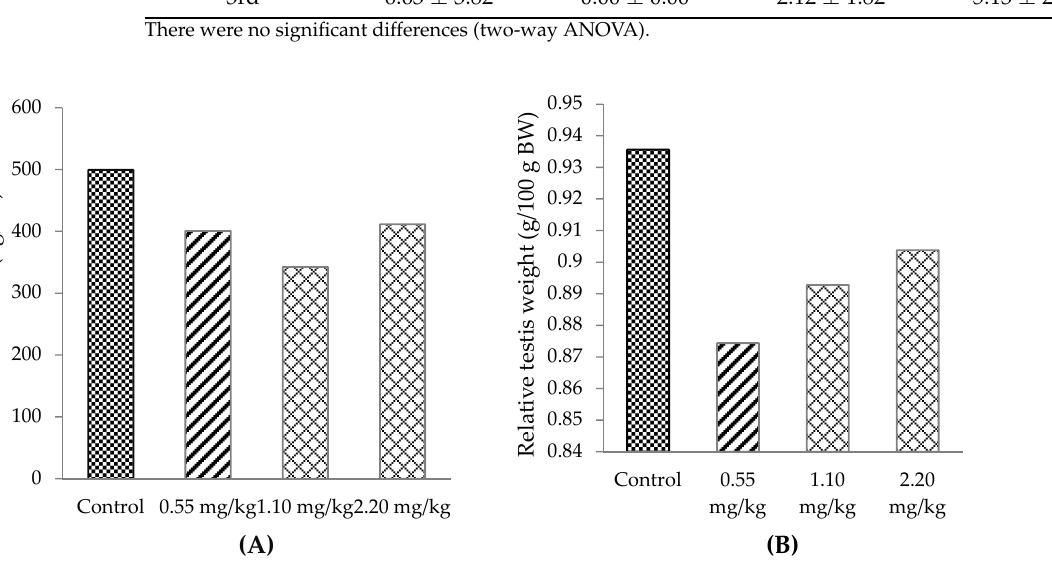
Figure 4. Testosterone hormone ( A ) and relative testis weight ( B ) of male rats administered different doses of M. oleifera leaf tea for 30 days (one-way ANOVA). There were no significant differences at p < 0.05. Data are mean values ± standard deviation (error bars).